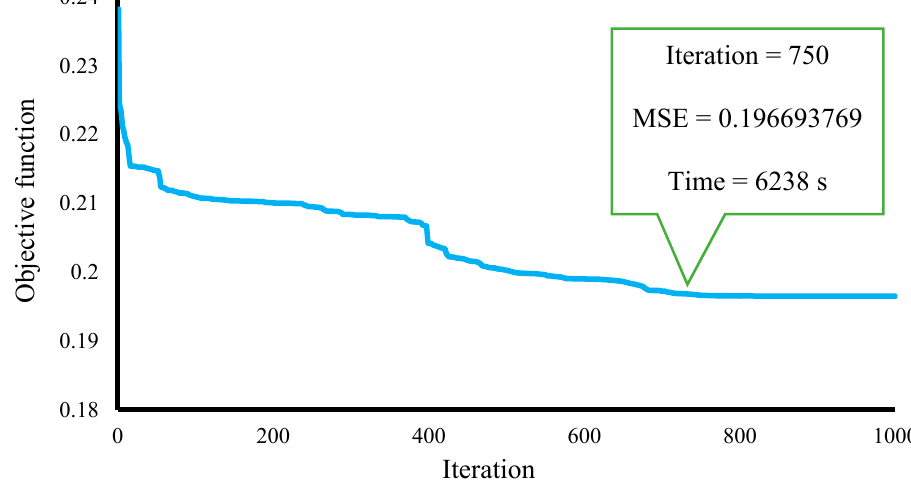
Figure 6. The convergence cure of the applied HHO–ANN model.